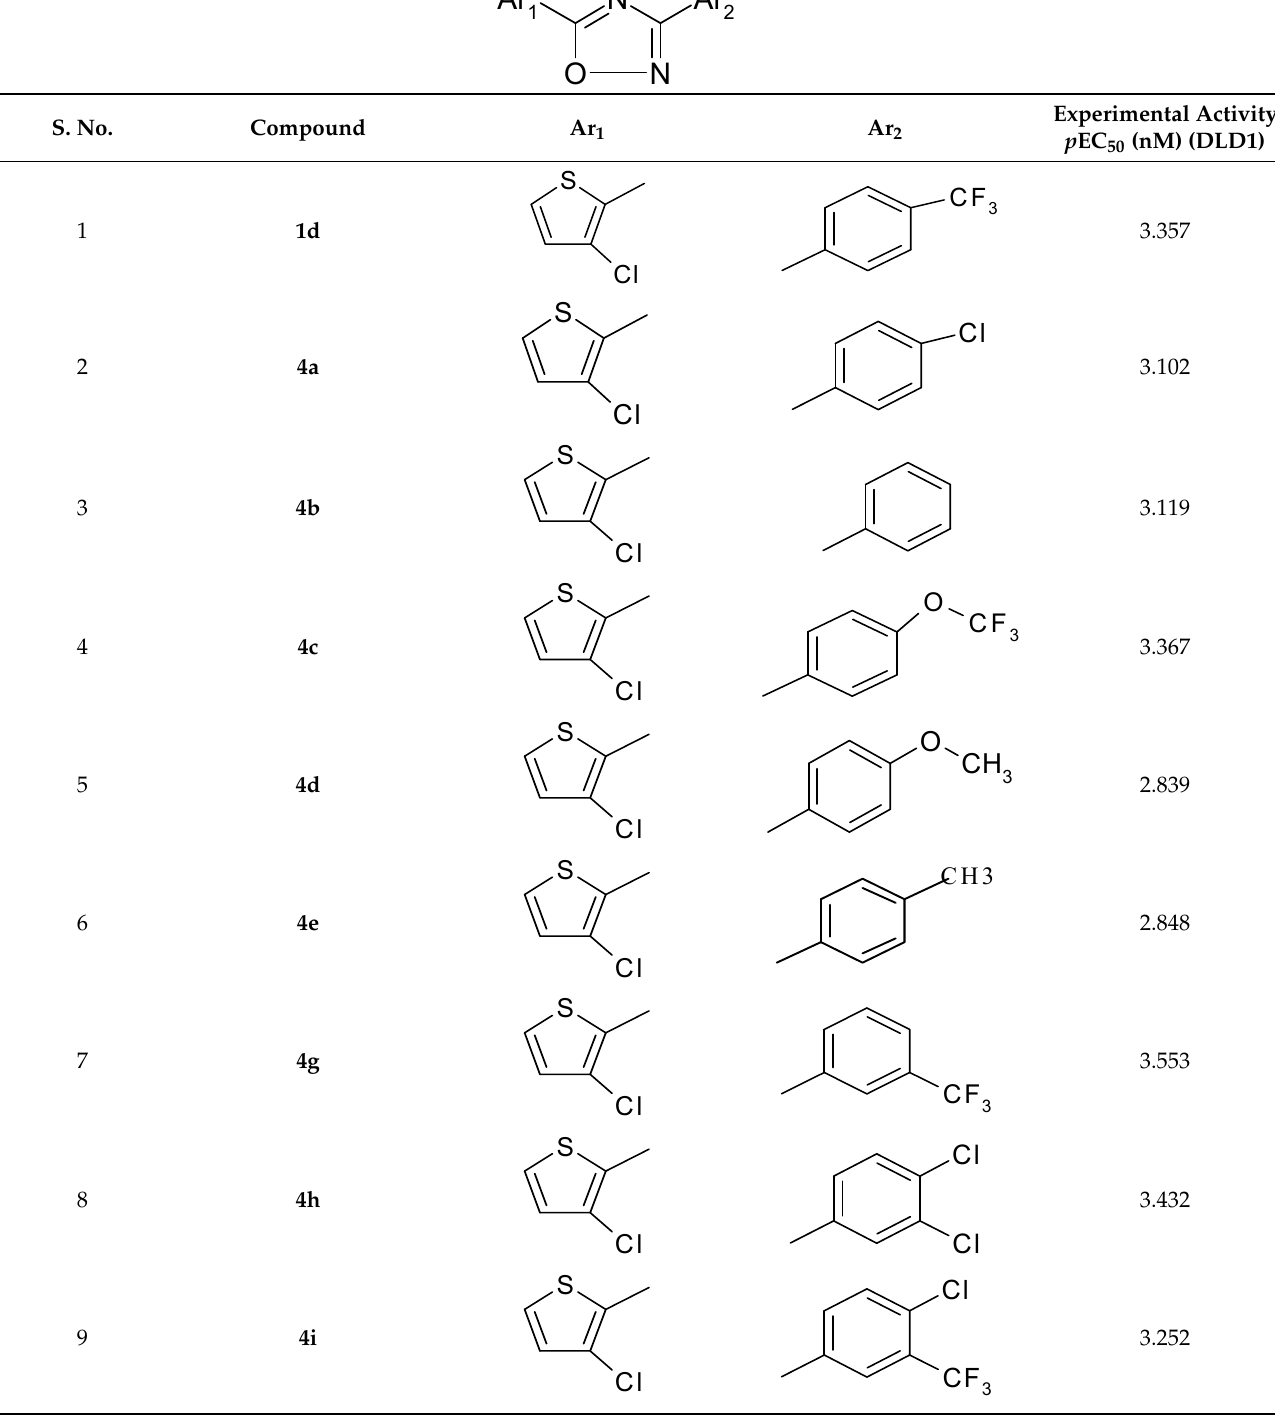
Table 1. 1,2,4-Oxadiazole analogues and their experimental caspase-3 activator activity.